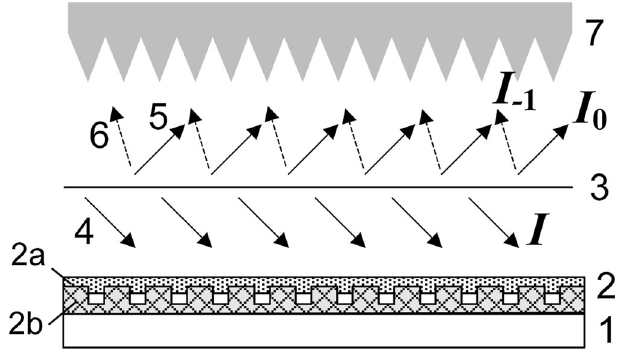
FIG. 3. Computational model of the active diffraction grating: 1—flat metal mirror, 2—dielectric plate with grooves (2a— quartz, 2b—Teflon), 3—plane with preset currents, which radi- ates the wave towards the grating, 4—wave incident on the grating, 5—reflected wave, 6—diffraction wave ( (cid:3) 1 st maxi- mum), 7—absorber (a medium with conductivity that grows linearly in the direction of wave propagation for absorption of the waves reflected from the diffraction grating).